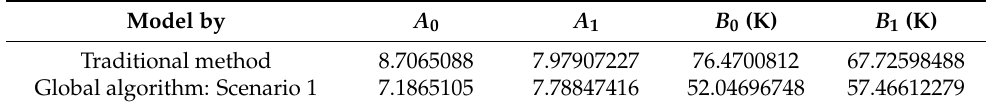
Table 3. Fitted coefficients of WLF for each case. Model by A 0 A 1